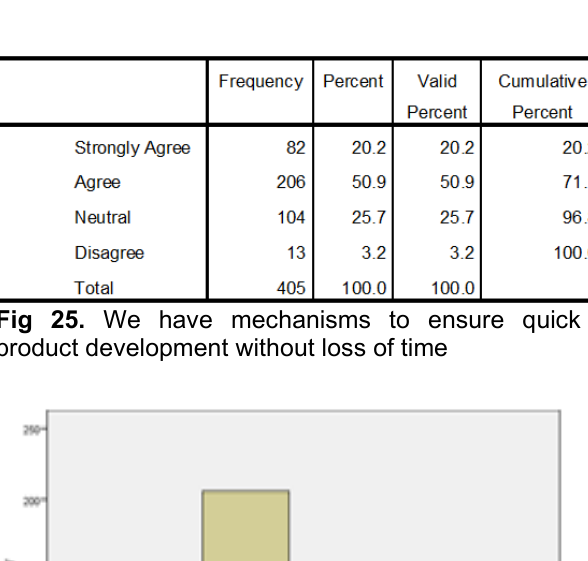
With respect to Fig 27 and 28, total number of 405 people